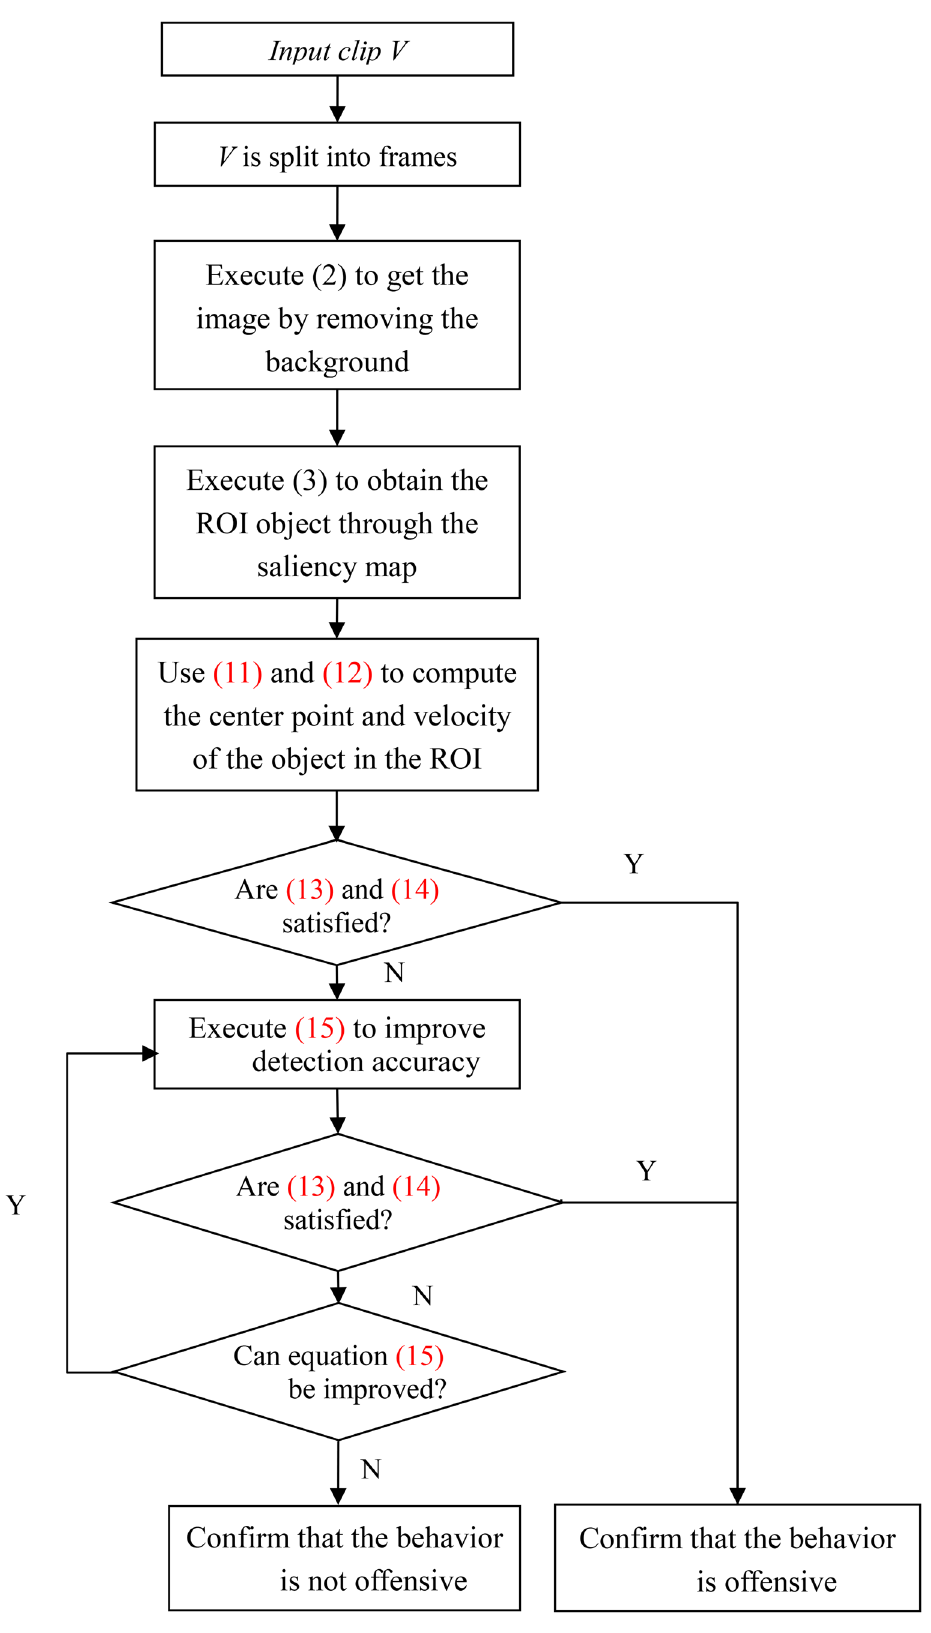
Figure 5. The flowchart of the proposed